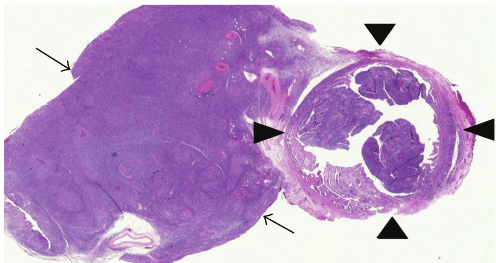
Figure 2: Low power photomicrograph showing sheets of lym- phoma cell replacing the usual histology of ovary (arrow) and infil- trating fallopian tube (arrow